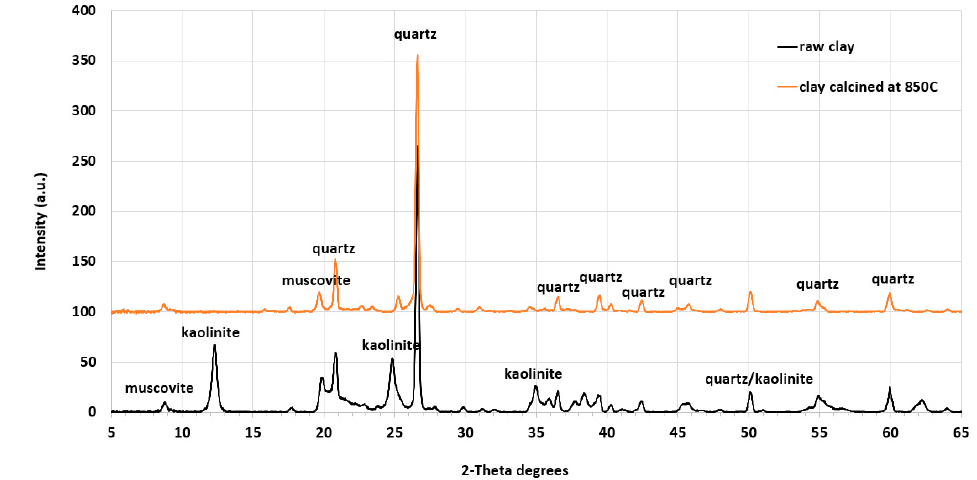
Figure 1. Mineral composition of the raw and calcined clay.